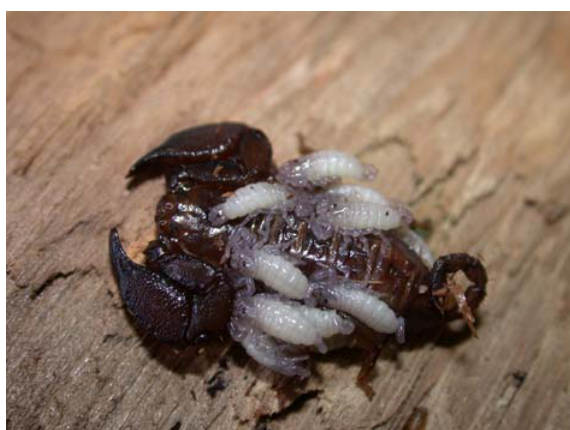
Figure 12. Female of Liocheles australasiae with